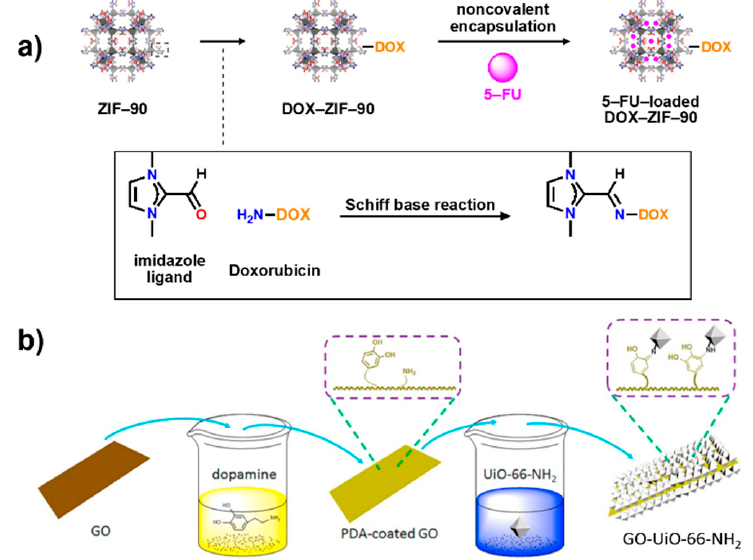
Figure 3. The preparations and structures of ( a ) DOX-ZIF-90 ( b ) GO-UiO-66-NH 2 . Figure 3b is reproduced with permission from Rao et al. [52]. Copyright 2017 Elsevier.